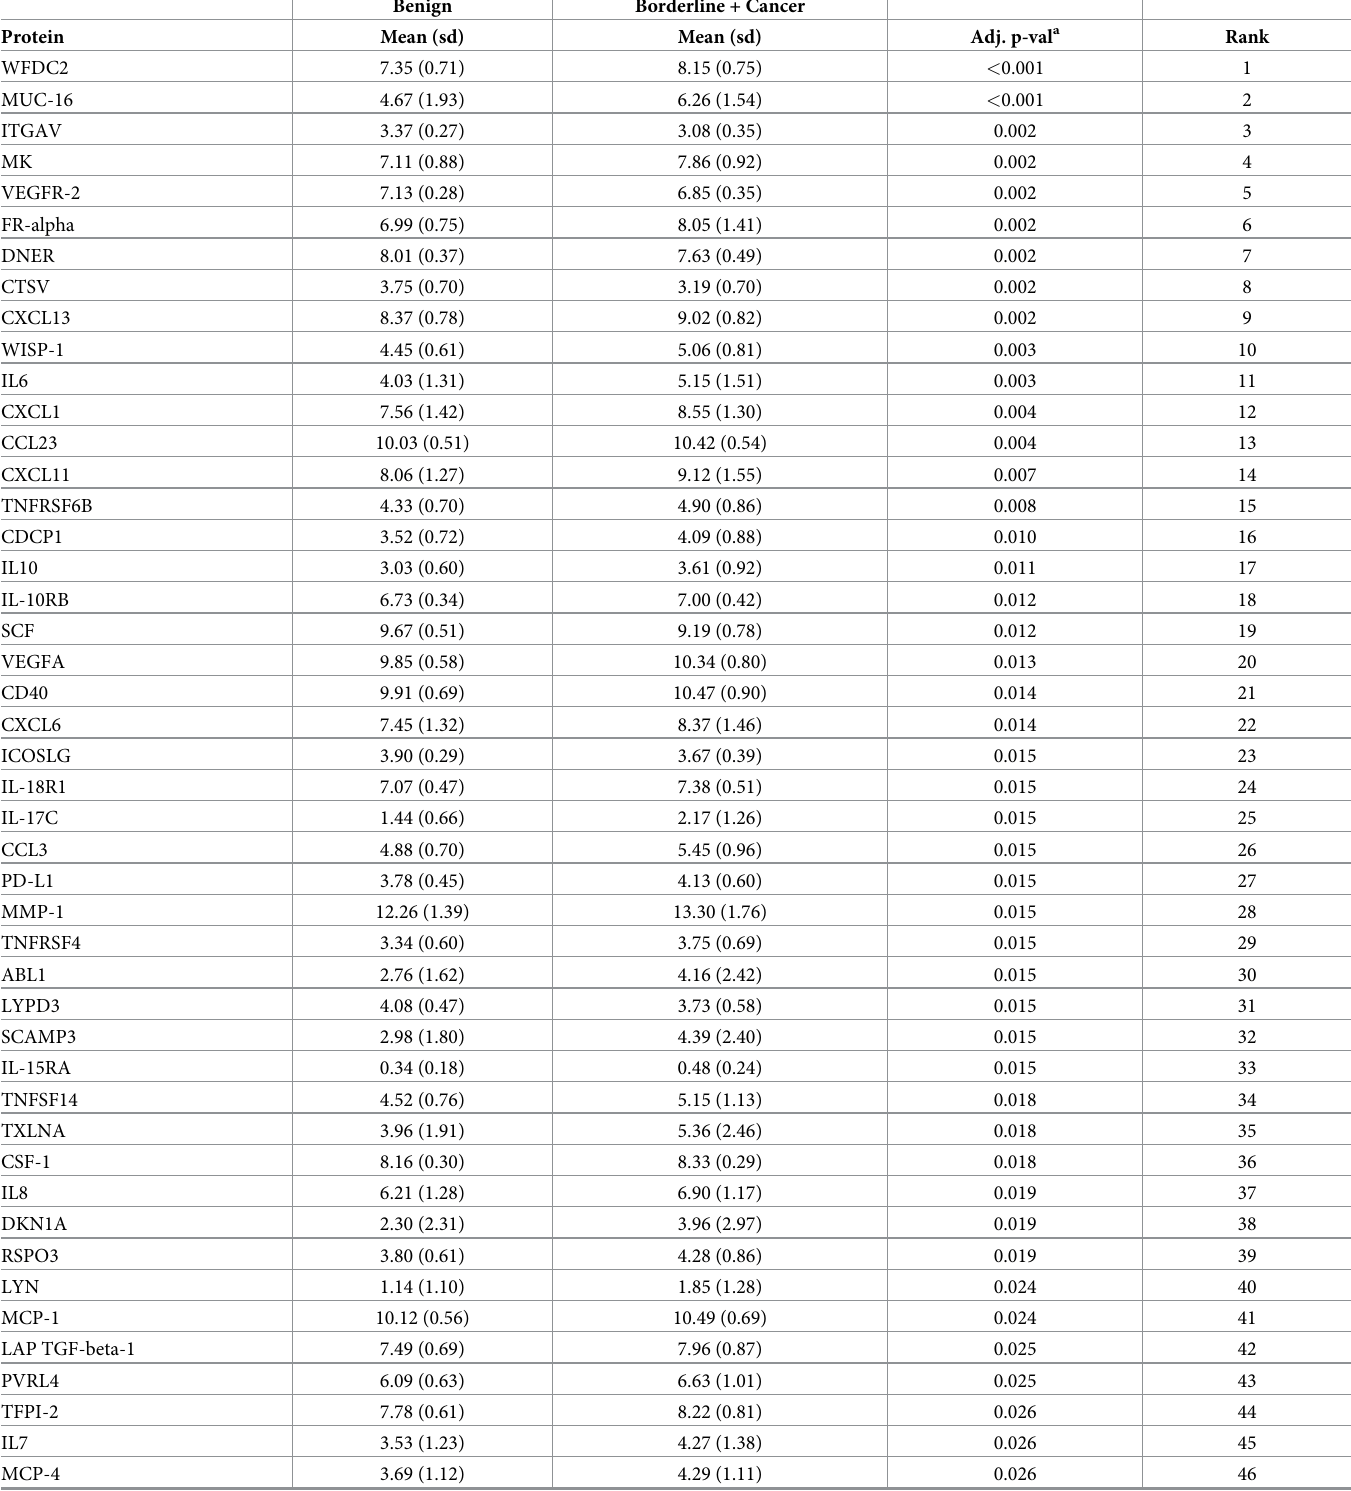
Table 6. Normalized protein expression (NPX) values. Benign tumors vs. borderline + cancer, p < 0.05.